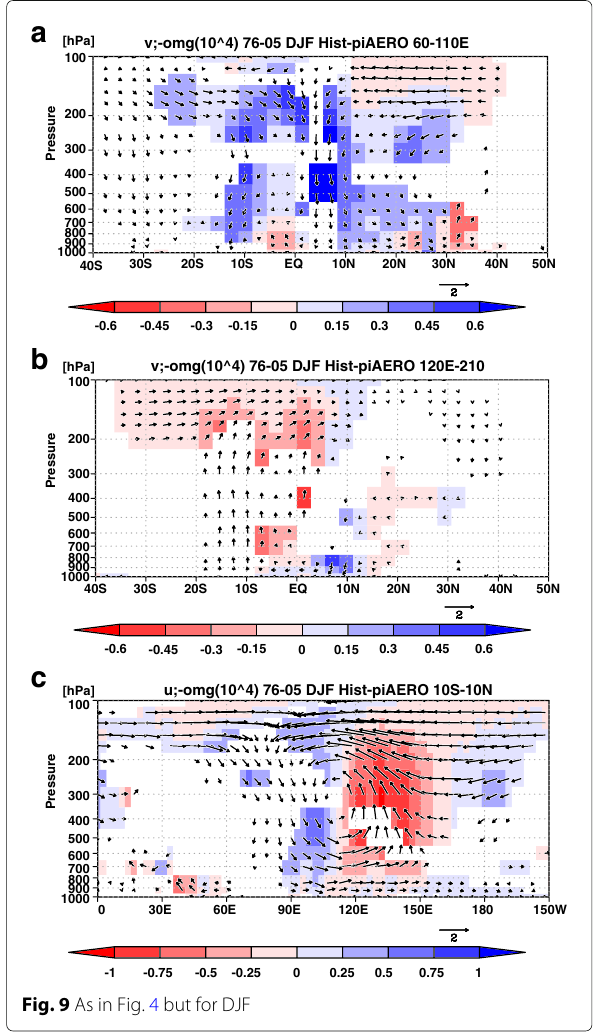
Fig. 9 As in Fig. 4 but for DJF